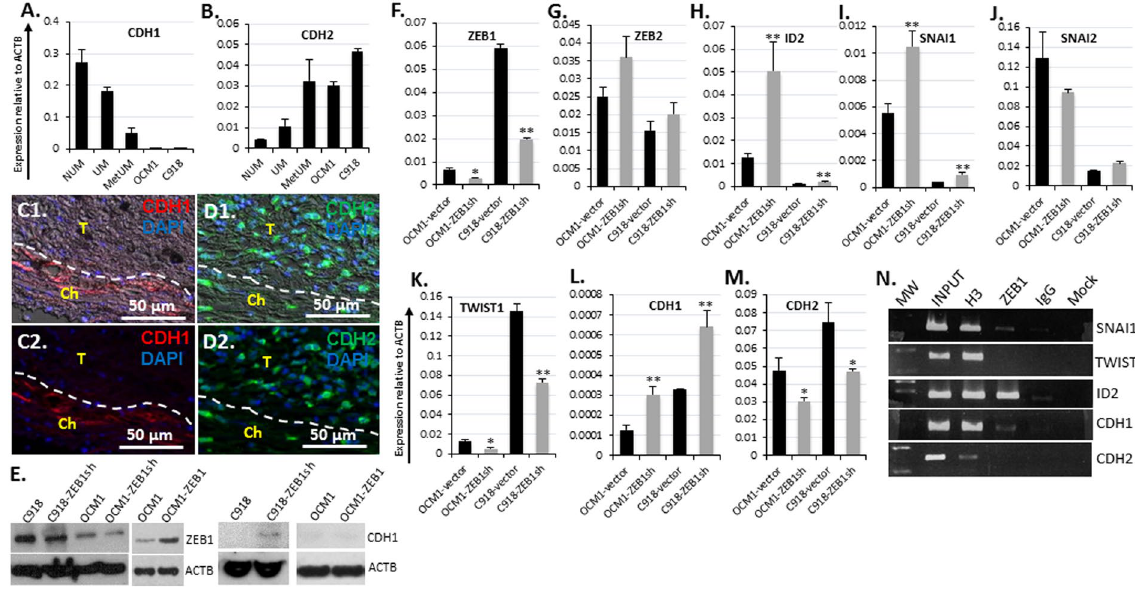
Figure 3. ZEB1 coordinates other EMT-TFs in transcriptional regulation of EMT molecules. Transcriptional expression levels of ( A ) the epithelial marker E-cadherin ( CDH1 ), ( B ) the mesenchymal marker N-cadherin ( CDH2 ) detected by qPCR in NUM, UM, MetUM, OCM1 and C918 were compared. The presence of ( C ) CDH1 in the choroidal tissue but not in the tumor, and (D) more CDH2 in the tumor than in the choroid was detected by immunohistochemistry. ( E ) ZEB1 knockdown in both C918 and OCM1 and ZEB1 overexpression in OCM1 were validated by Western blots (WB). Knockdown of ZEB1 resulted in CDH1 accumulation in C918. Real-time qPCR analyses of the effects of ( F ) ZEB1 knockdown on the expression of the other EMT-TF genes including ( G ) ZEB2 , ( H ) ID2 , ( I ) SNAI1 , ( J ) SNAI2 , ( K ) TWIST1 , and EMT marker genes including ( L ) CDH1 , and ( M ) CDH2 . ( N ) Chromatin immune-precipitated (ChIP) by ZEB1 antiserum (ZEB1) was utilized to detect the binding of ZEB1 to the EMT-TF genes SNAI1 , TWIST1 and ID2 , and to the EMT marker genes CDH1 and CDH2 . Molecular weight (MW) marks were loaded on the far left lane for validation of ChIP-PCR amplicon size, followed by 10x diluted chromatin sample before immuneprecipitation (INPUT). Pan histone 3 (H3) and pre-immune serum (IgG) were served as a positive and a negative control, respectively, whereas any remaining chromatin after passing through the binding beads without any serum was served as a background control (Mock). Mean (M) ± standard deviation (SD). ‘ * ’ Indicates Student’s t-test p ≤ 0.05, ‘ ** ’ Indicates Student’s t-test p ≤